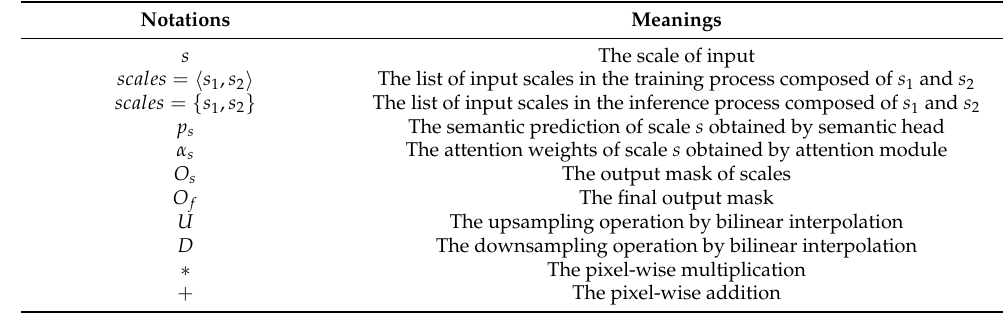
Table 3. Notations and meanings for the proposed